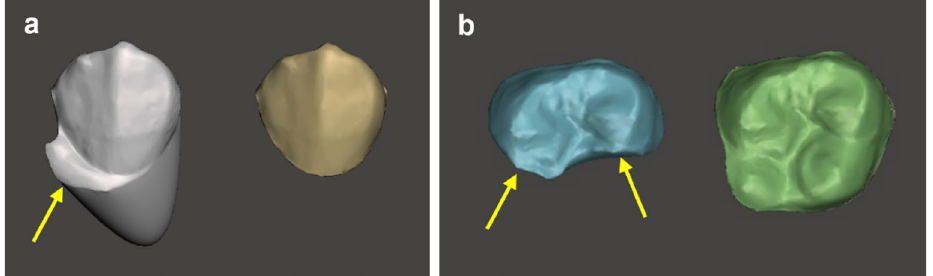
Figure 5. Examples of segmentation failure; an arrow marks the part with segmentation failure. ( a ) Left: segmented tooth beyond the gingival margin; right: reference tooth. ( b ) Left: segmented tooth with partial loss of occlusal surface; right: reference